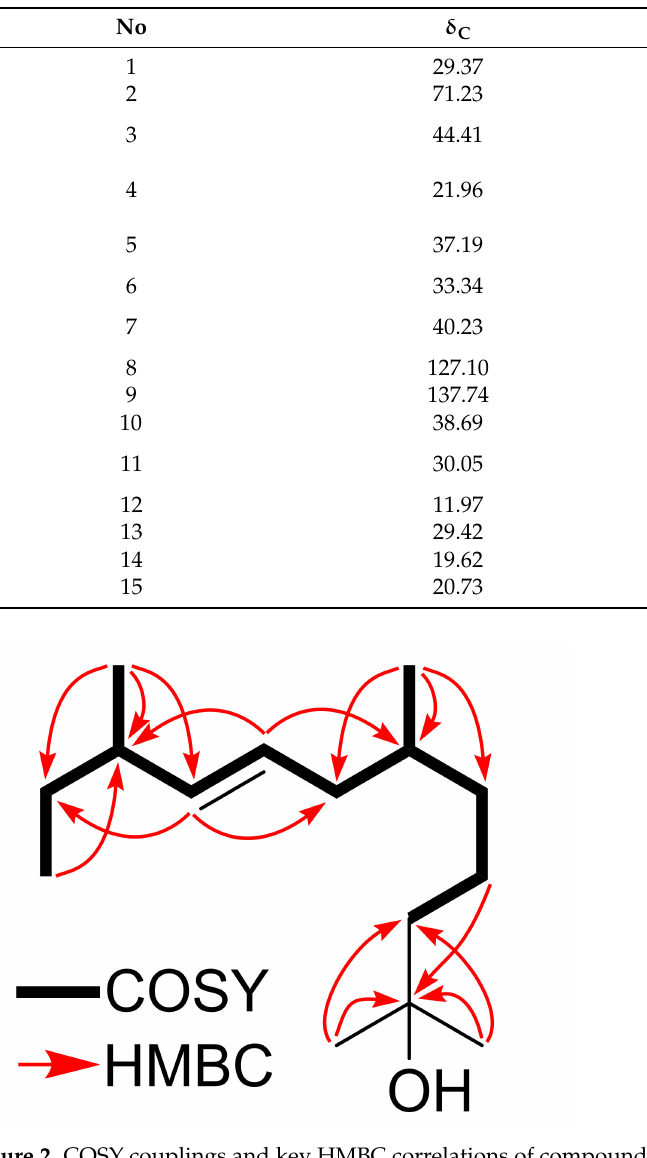
Figure 2. COSY couplings and key HMBC correlations of compound 1